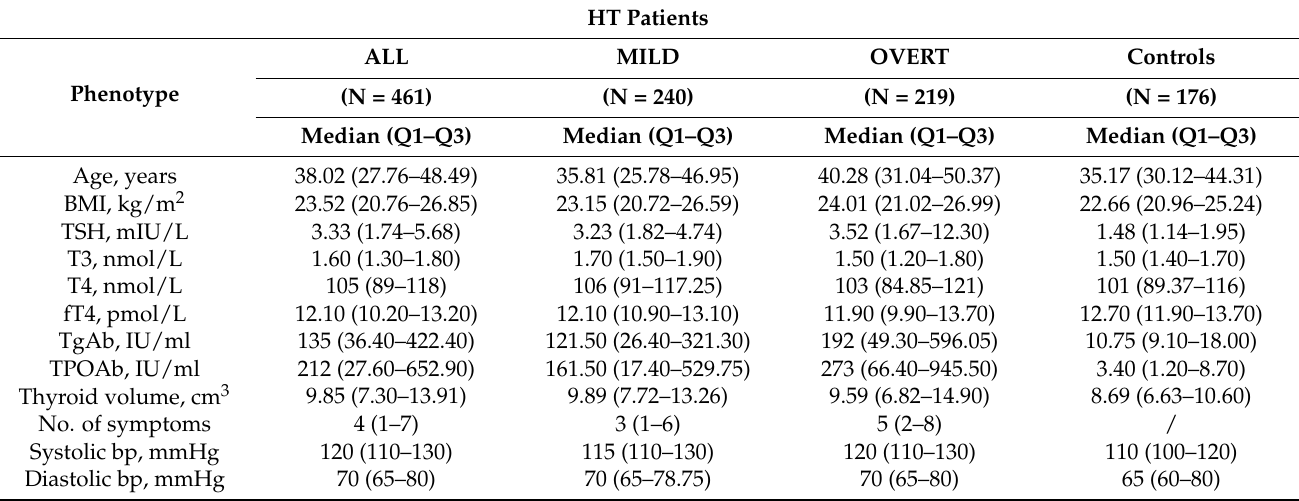
Table 1. Clinical characteristics of HT patients and control